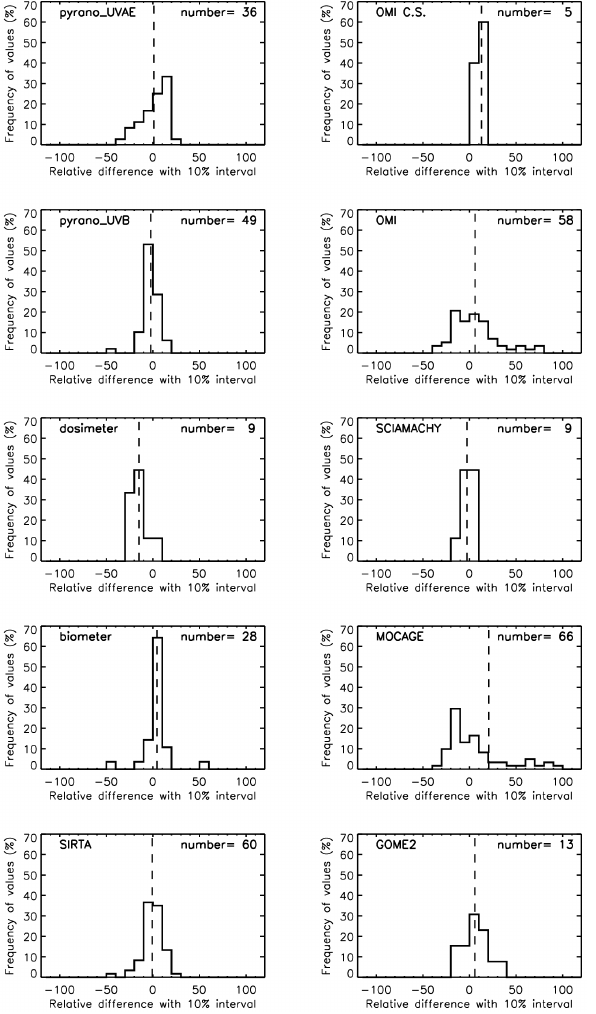
Fig. 9. The histograms represent the frequency of values (in per- cent) which deviated from the spectrometer observations. The devi- ations are expressed in percent and the observations are binned with 10% intervals. The figure shows on the left the SIRTA instruments histograms and on the right the satellites and MOCAGE histograms. The number of observations is added on the top right figures. The arithmetic averages are overplotted with dashed lines to highlight the characteristics of the